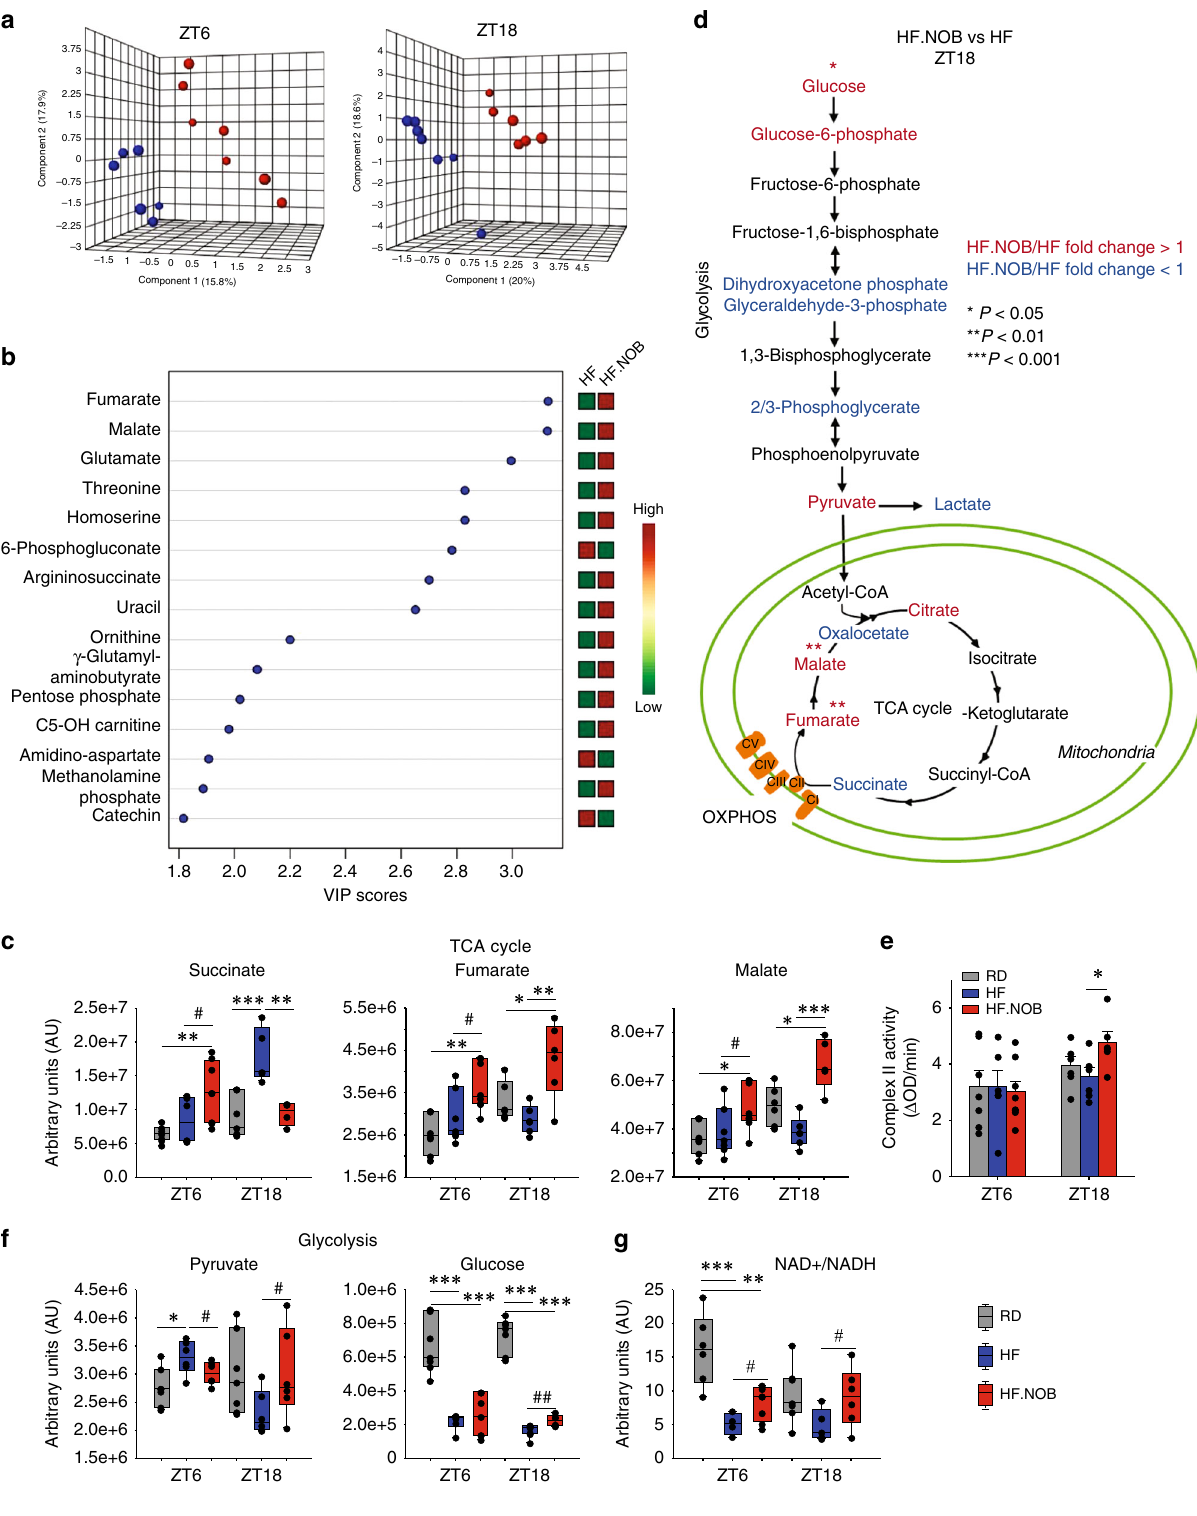
we observed prevalent changes in metabolites involved in mito- chondrial metabolism. Partial least-squares Discriminant Analy- sis (PLS-DA) and corresponding Variable Importance in Projection (VIP) analysis, which evaluates and ranks the con- tribution of metabolites to PLS-DA variance based on the weighted sum of squares for PLS loadings, revealed most robust NATURE COMMUNICATIONS| (2019) 10:3923